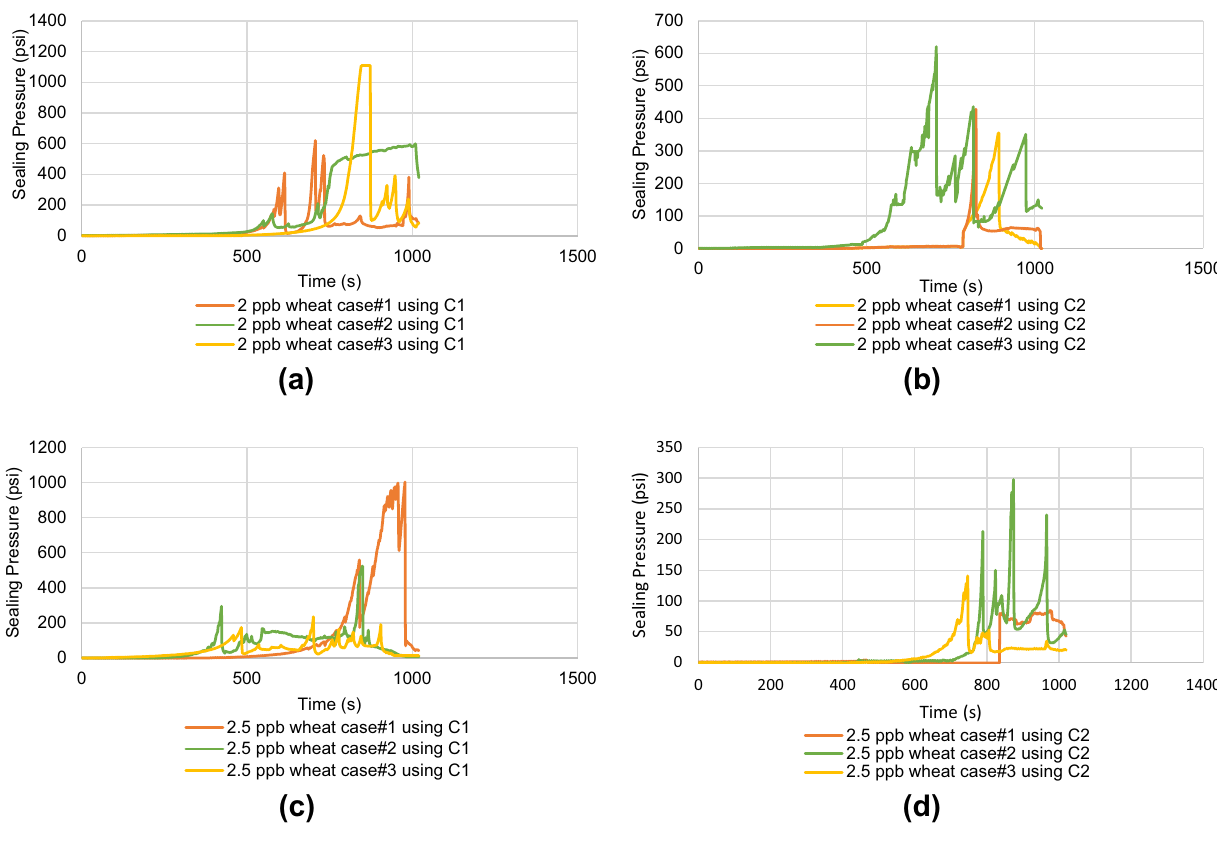
Fig. 22 HPA Pressure versus Time plot for 2 & 2.5 ppb Wheat Straw showing maximum sealing pressure at different cases using C1 and